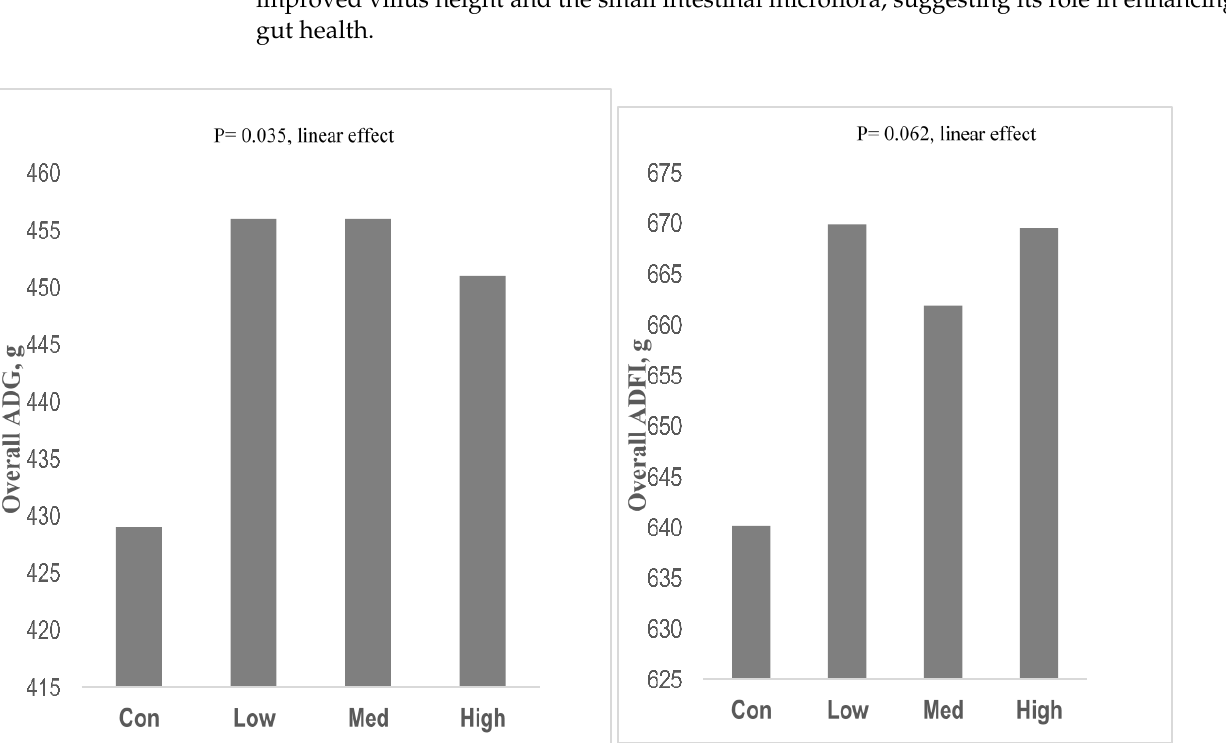
Figure 2. Effect of dietary supplementation of increasing dose of coated sodium butyrate acid on the overall average daily gain (ADG) and average daily feed intake (ADFI) of weaning pigs. Con, basal diet (lactose and sodium reduced); Low, Con + 0.5 kg/ton coated sodium butyrate; Med, Con + 1.5 kg/ton coated sodium butyrate and after 3 weeks Con + 0.75 kg/ton; High, Con + 3.0 kg/ton coated sodium butyrate and after 3 weeks Con + 1.50 kg/ton.